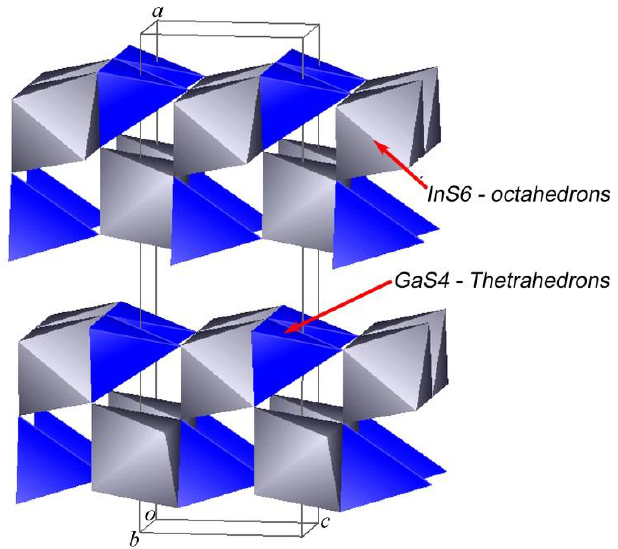
Figure 1. Crystal structure of the orthorhombic In 1.2 Ga 0.8 S 3